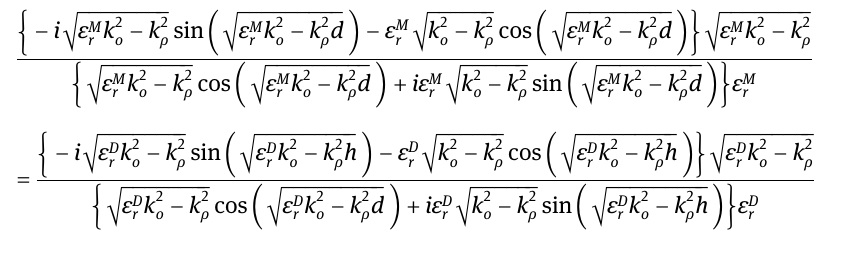
The far-field radiation pattern of photon sieve struc- tures can be characterized using an angle-resolved CL map. Delmic SPARC CL 1 detector installed in a Zeiss SIGMA fi eld emission scanning electron microscope 2 was used for experimental analysis of these structures. Photon sieve with fourfold structural symmetry was created by projec- ting a square lattice of varying holes from the Cartesian coordinate system to a spherical coordinate system (Figure 11A). The obtained CL map comprises fourfold symmetry, with peak intensities forming into hyperbolic lines (Figure 11E and I). The CL maps at various wave- lengths support the same symmetry pro fi le, though with varying number of hyperbolic lines. Structures with sixfold